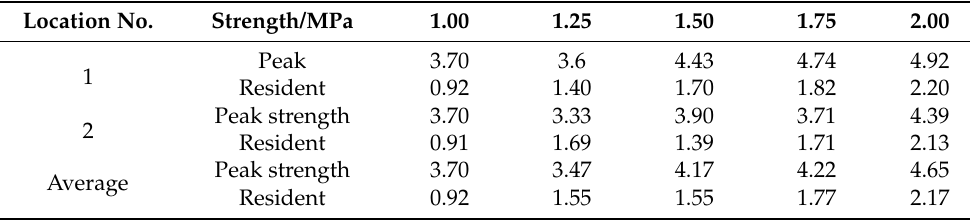
Figure 3. The in-situ direct shear results. ( a ) Shear test data at Location #1, ( b ) Shear test data at Location #2. Table 1. Tested data of concrete-rock interface under various normal stresses. Location